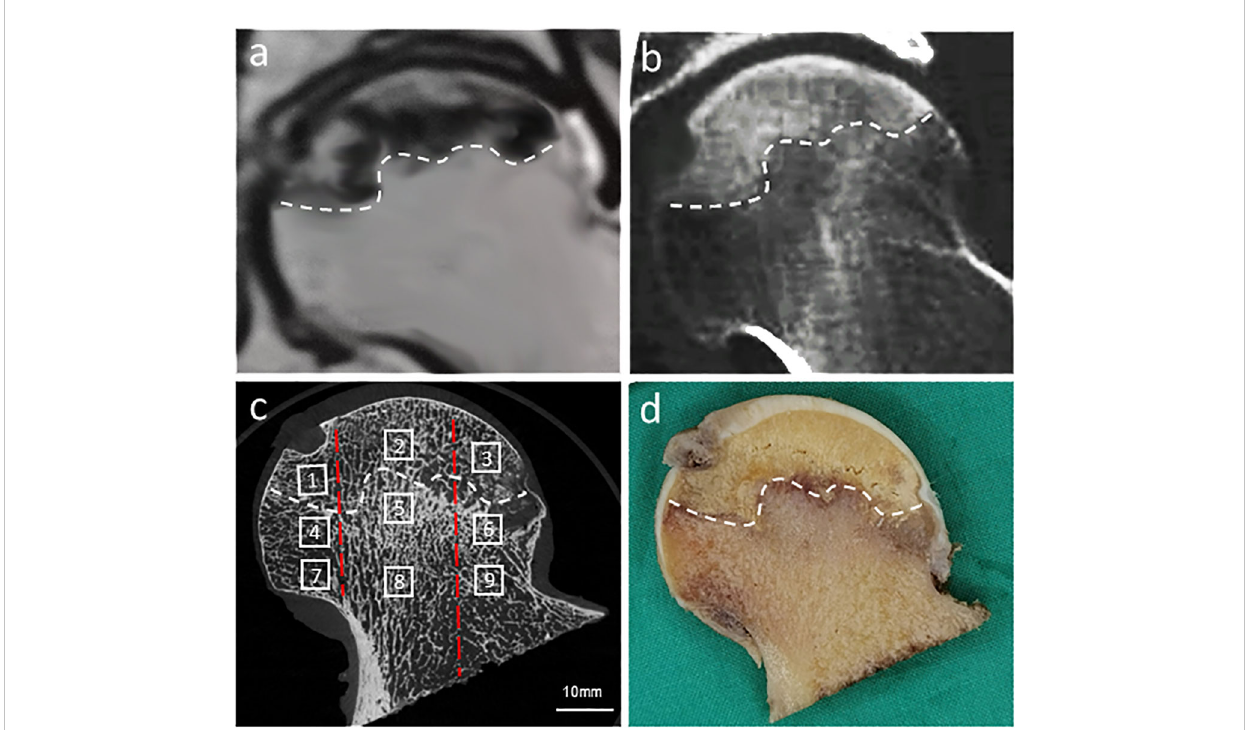
FIGURE 2 Location, orientation and segmentation of different regions of interest (ROIs) in the femoral head. A high degree of consistency was demonstrated between MR image (A) , CT image (B) , corresponding micro-CT image (C) , and gross examination of the coronal plane of the femoral head (D) . In each femoral head, 9 ROIs were set in the necrotic region (1, Sup-Med; 2, Sup-Cen; 3, Sup-Lat), reactive interface (4, Cen-Med; 5, Cen-Cen; 6, Cen-Lat), and normal region (7, Inf-Med; 8, Inf-Cen; 9, Inf-Lat). The white dotted line indicated the reactive interface, while the two red dotted lines divided the femoral head into three regions in the medio-lateral orientation: medial region, central region, and lateral region based on the CJFH three-pillar